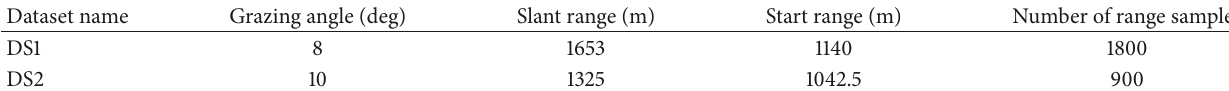
Table 2: Main configurations of the analyzed datasets.